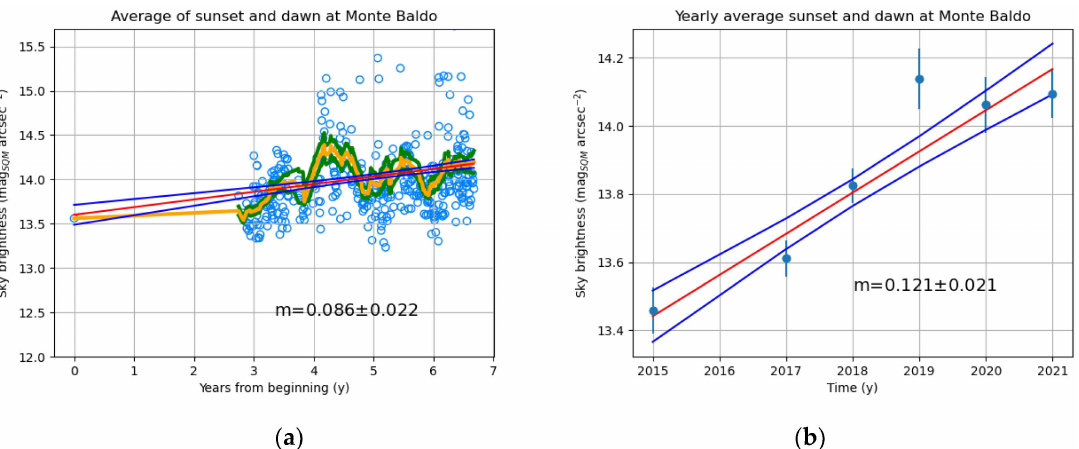
Figure 11. Trends of the sky brightness at zenith at Monte Baldo: average values at sunset and dawn ( a ) with their moving average (yellow curve) and aside the green curves accounting for one standard deviation ( a ) and the annual average values ( b ) when the Sun altitude is around − 6.5 ◦ , the red line is the linear fitting and the blue curves account for the uncertainty on the fitting parameters.